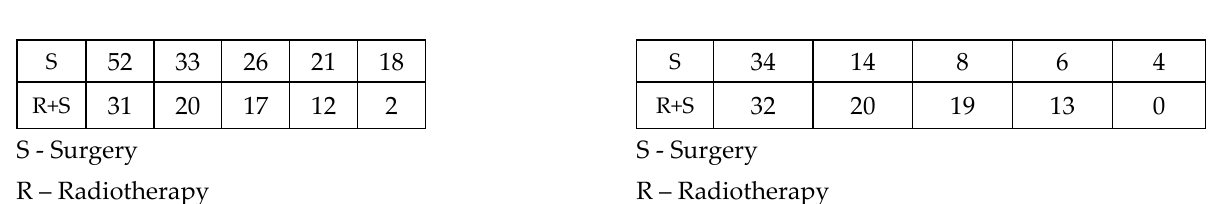
Figure 3. Recurrence-free survival. ( A ) For all patients, log-rank p = 0.001 . ( B ) For stage (y)pI patients, log-rank p = 0.014 . ( C ) For stage (y)pII patients, log-rank p = 0.184 . ( D ) For stage (y)pIII patients, log-rank p = 0.077.